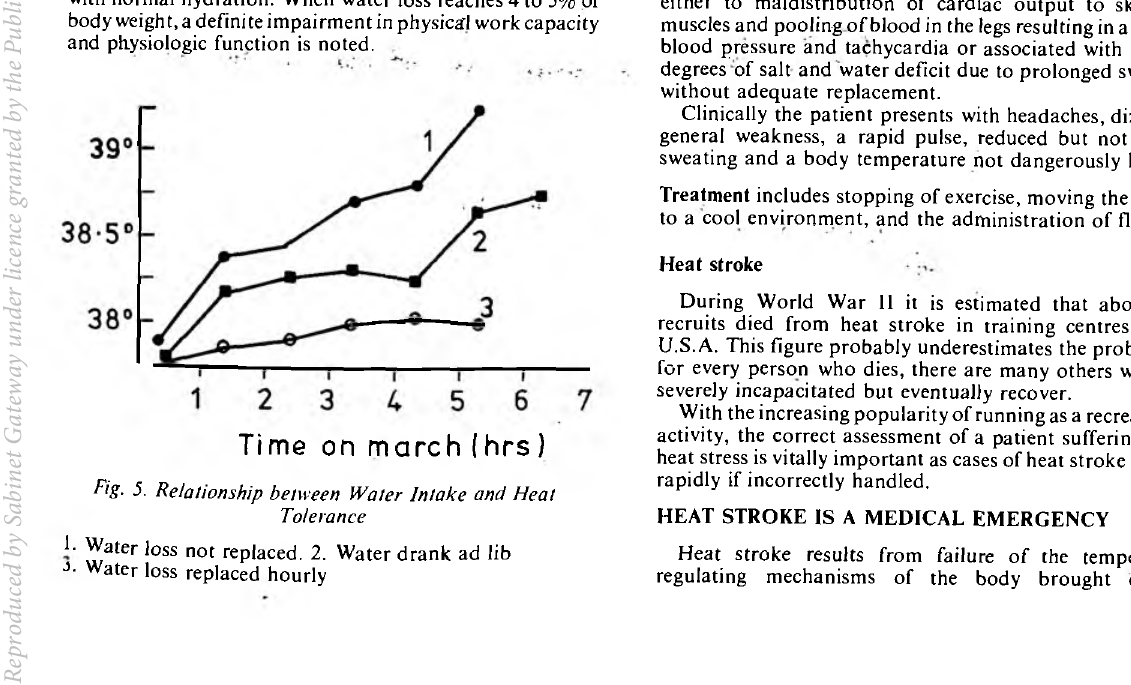
Fig. 5. Relationship between Water Intake and Heat Tolerance 1. Water loss not replaced. 2. Water drank ad lib J. Water loss replaced